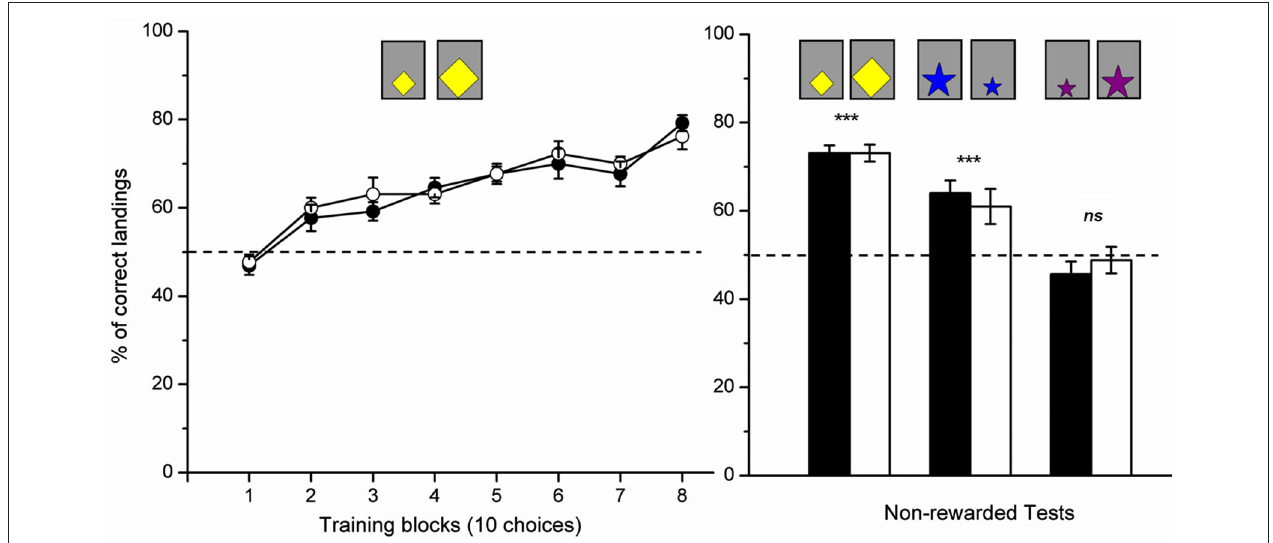
white. The dashed line indicates chance level performance. Data shown are means +s.e.m. n = 26 for the acquisition curve and learning test. 10 of the 26